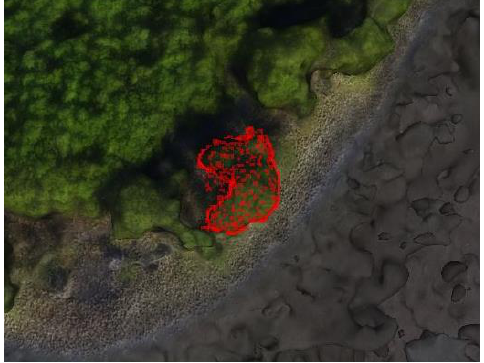
Figure 4. Tree crown selection in MeshLab